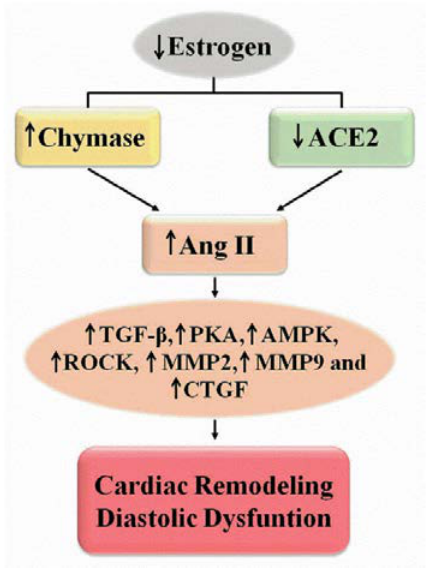
Figure 2. Estrogen depletion induces increased cardiac Ang II. ACE2—angiotensinogen-converting enzyme 2; AMPK—AMP kinase; CTGF—connective tissue growth factor; MMP—matrix metalloproteinase; PKA—protein kinase A; ROCK—Rho kinase; TGF- β —transforming growth factor beta.